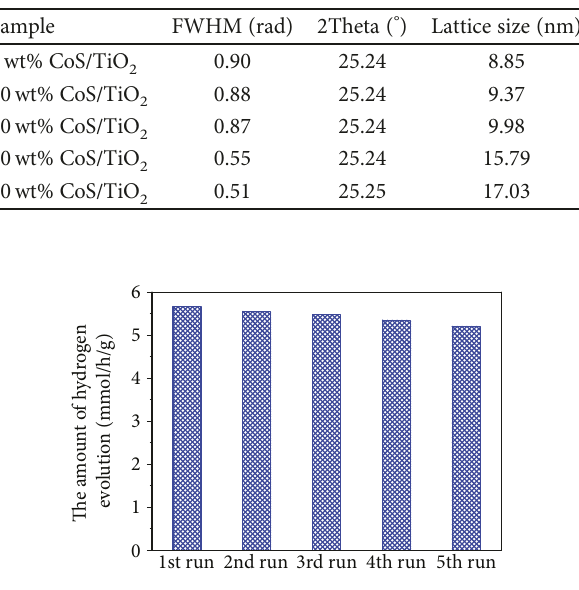
for photocatalytic 2